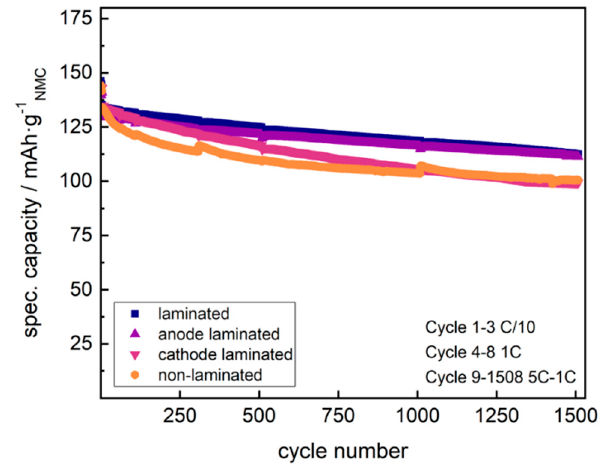
Figure 5. Discharge capacity data of laminated / partially laminated / non-laminated cells in fast-charging cycle test; charge at 5 C CCCV mode, discharge at 1 C CC mode.